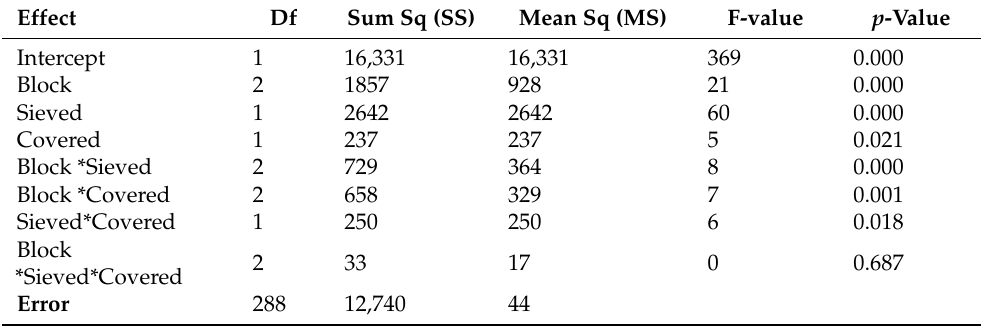
Table 3. ANOVA table for the difference in Moisture content (w.b) during storage of wood chips. Effect